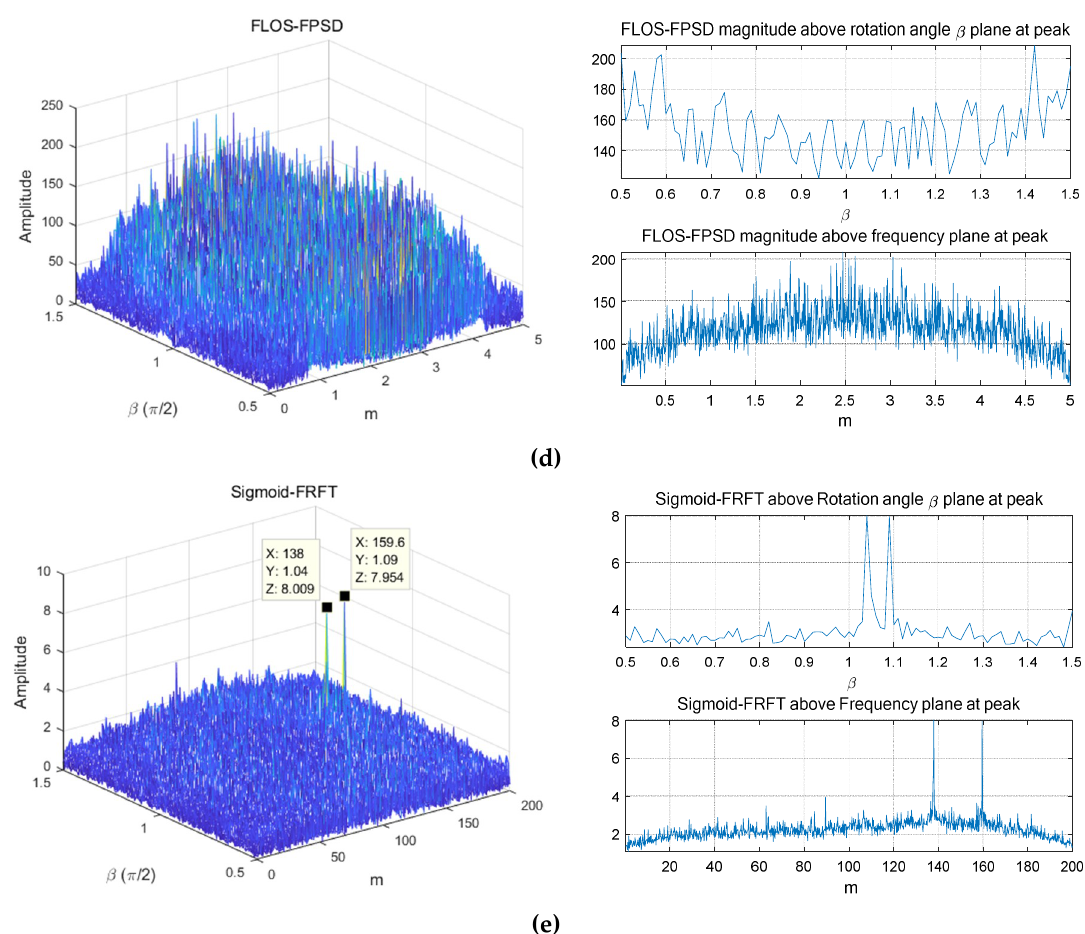
Figure 3. The spectrum of FRFT, the fractional correlation based on fractional lower-order statistic (FLOS-FC), the fractional lower order statistics and fractional power spectrum density (FLOS-FPSD) and Sigmoid-FRFT with impulsive noise (GSNR = 5 dB and α = 1.2). ( a ) The FRFT spectrum of the echo signal without noise and its rotation angle and frequency section planes; ( b ) the FRFT spectrum of the echo signal with impulsive noise and its rotation angle and frequency section planes; ( c ) the FLOS-FC spectrum of the echo signal with impulsive noise and its rotation angle and delay section planes; ( d ) the FLOS-FPSD spectrum of the echo signal with impulsive noise and its rotation angle and frequency section planes; ( e ) the Sigmoid-FRFT spectrum of the echo signal with impulsive noise and its rotation angle frequency section planes.